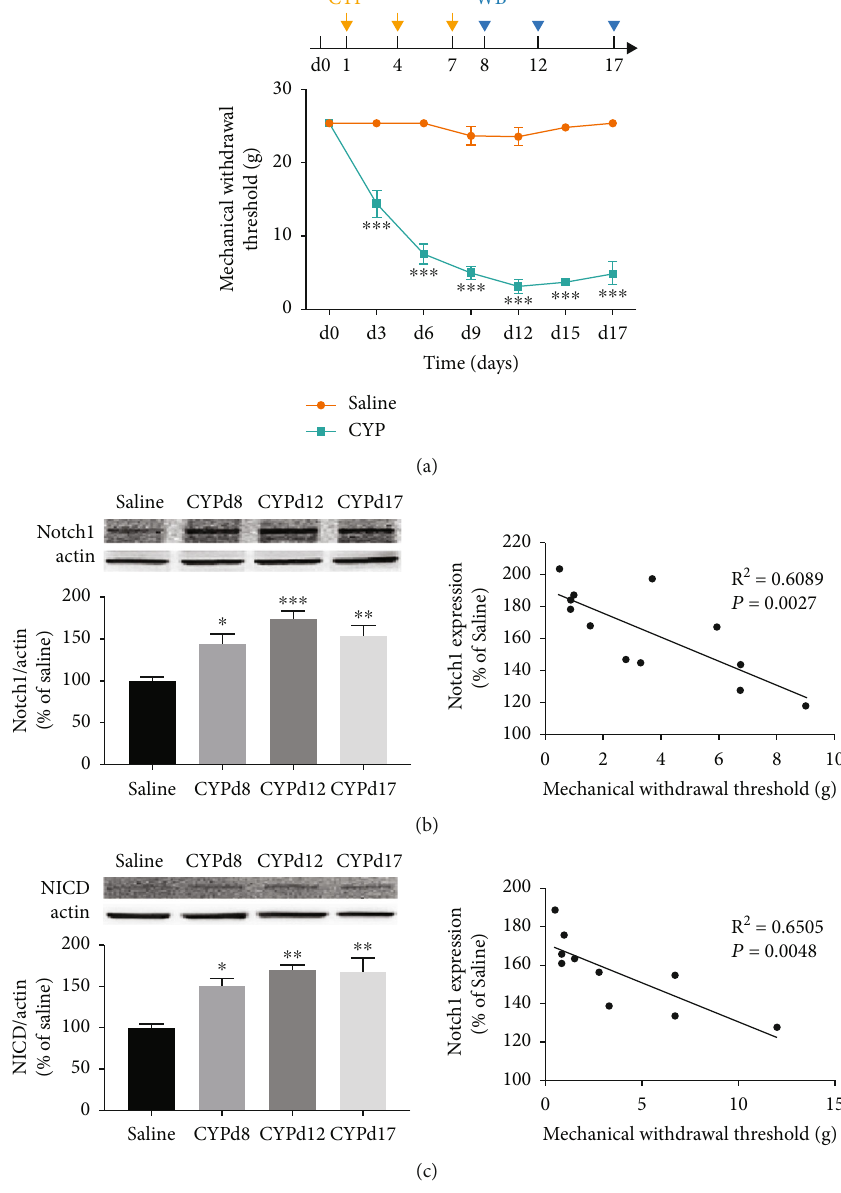
Figure 1: Notch1 signaling was upregulated in the spinal dorsal horn (SDH) of the CYP-induced cystitis model. (a) The mechanical withdrawal threshold of the CYP-induced cystitis model was signi fi cantly reduced since the fi rst CYP injection and remained for at least 17 days. n = 15 per group. The data were analyzed by two-way ANOVA followed by the Tukey post hoc test. (b) The expressions of Notch1 protein were signi fi cantly upregulated at all three time points (days 8, 12, and 17 after the onset of CYP injection). And the expression of Notch1 was negatively correlated with the mechanical withdrawal threshold of the cystitis animals. n = 5 per group. (c) The expressions of NICD protein were signi fi cantly upregulated at all three time points. And the expression of NICD was also negatively correlated with the mechanical withdrawal threshold of the cystitis animals. n = 4 per group. Data in (b) and (c) were analyzed by one-way ANOVA followed by the Tukey post hoc test and linear regression. The correlation coe ffi cients were calculated. ∗ P < 0 : 05 , ∗∗ P < 0 : 01 , and ∗∗∗ P < 0 : 001 vs. saline